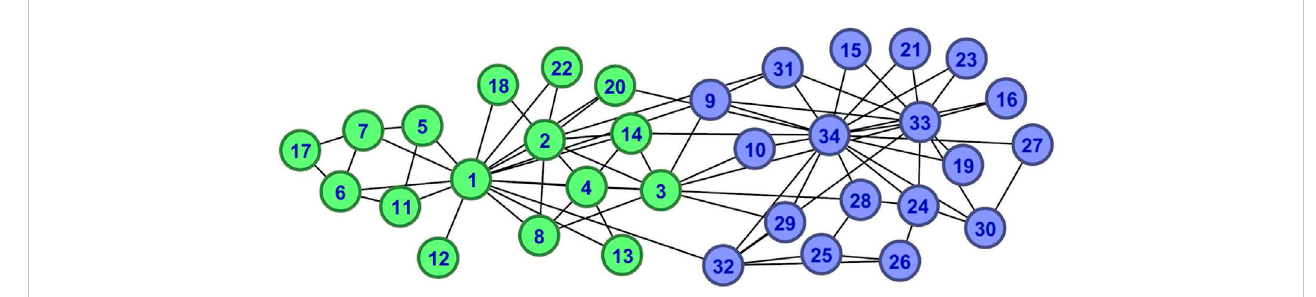
FIGURE 2 The node distribution of the Karate network .